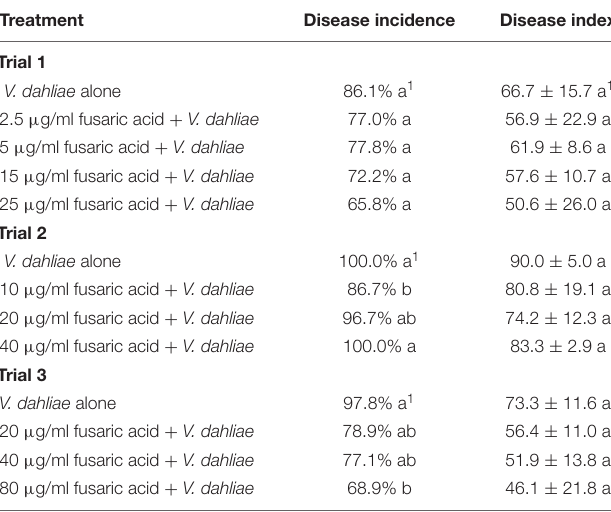
TABLE 7 | Effects of the different concentrations of fusaric acid on cotton Verticillium wilt in greenhouse experiment. Treatment Disease incidence Disease index